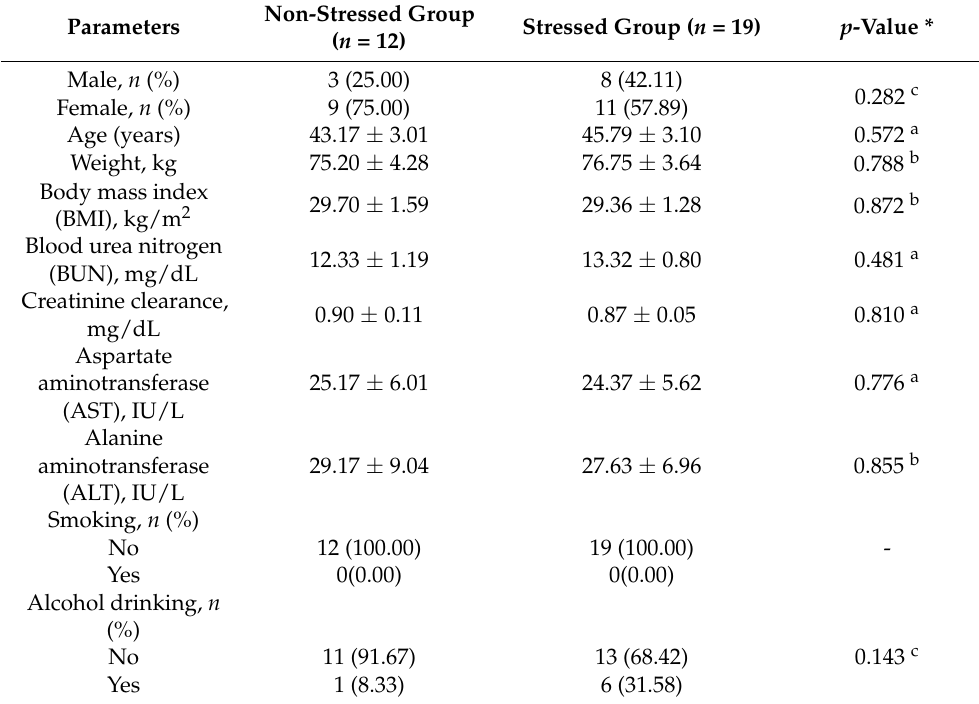
Table 2. Characteristics of participants at the